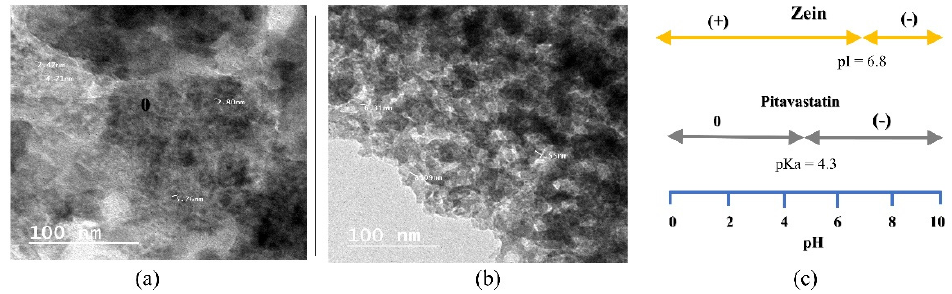
Figure 4. TEM micrographs of ( a ) non-doped BG and ( b ) BGT 5 . ( c ) A representation of the electrostatic interaction between zein and pitavastatin.